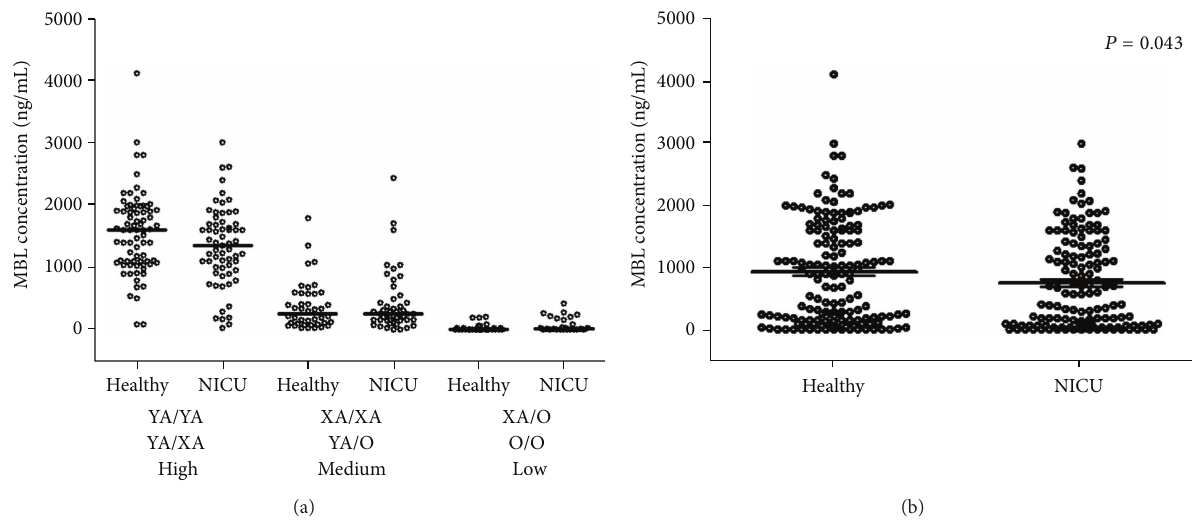
Figure 2: (a) Scatterplot of MBL serum levels in the neonates of the study, according to the high, medium, and low MBL2 genotype expression groups (corresponding MBL2 haplotypes are shown). Median is illustrated. (b) Scatterplot of MBL serum levels in healthy and NICU neonates of the study.